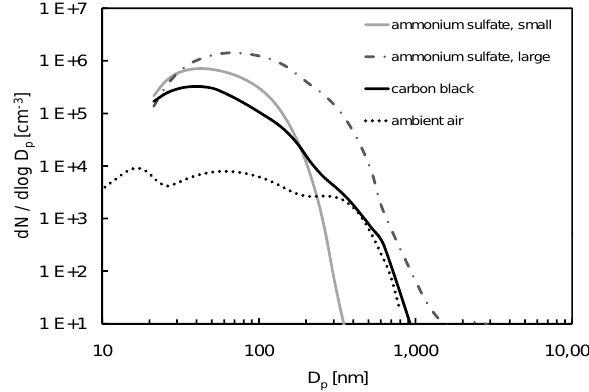
Fig. 2. Particle number size distributions for ambient air, ammo- nium sulfate, and carbon black during GAW2005. The particle number size distribution is a composite of number size distributions measured with a SMPS and an APS.